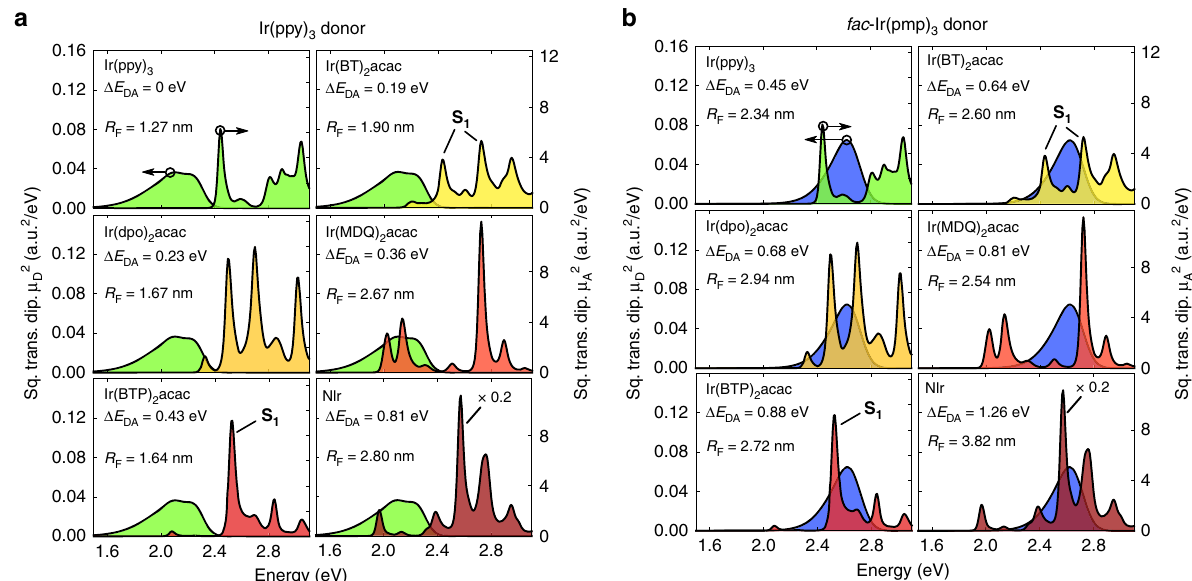
Fig. 3 Calculated squared transition dipole moment spectra for selected donor – acceptor pairs. a , b The Ir(ppy) 3 and fac -Ir(pmp) 3 donor spectrum, respectively, together with the Ir(ppy) 3 , Ir(BT) 2 (acac), Ir(dpo) 2 acac, Ir(MDQ) 2 acac, Ir(BTP) 2 (acac), and NIr acceptor spectra. Each panel also gives the Förster radius for the exciton transfer in the corresponding donor – acceptor system. For Ir(BT) 2 (acac) and Ir(BTP) 2 (acac) the peaks with strong S 1 character are indicated.